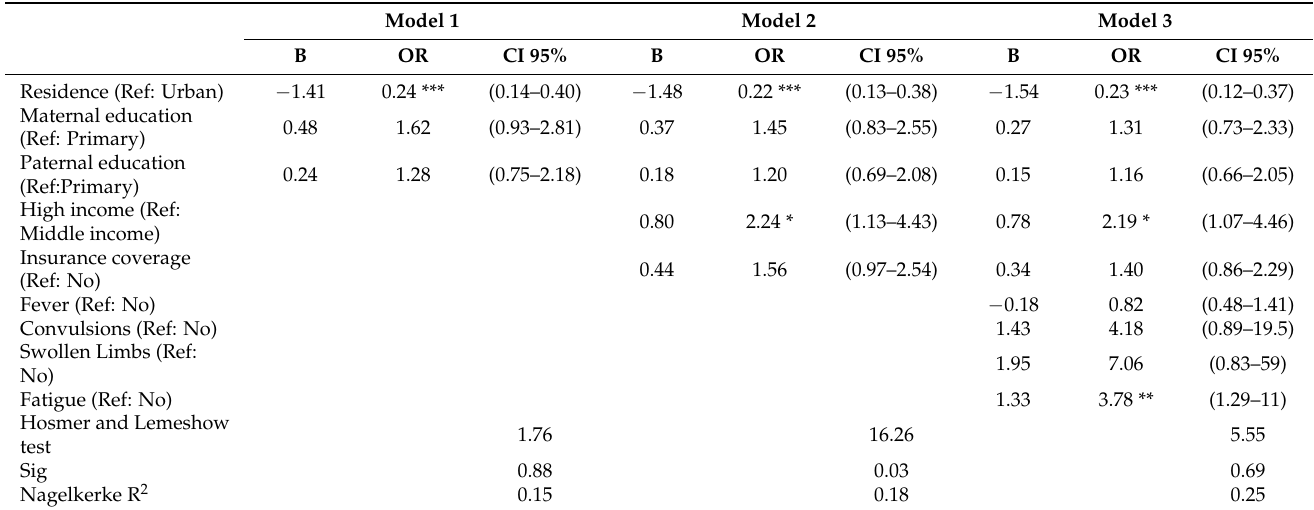
Table 5. Hierarchical logistic regression models for place of